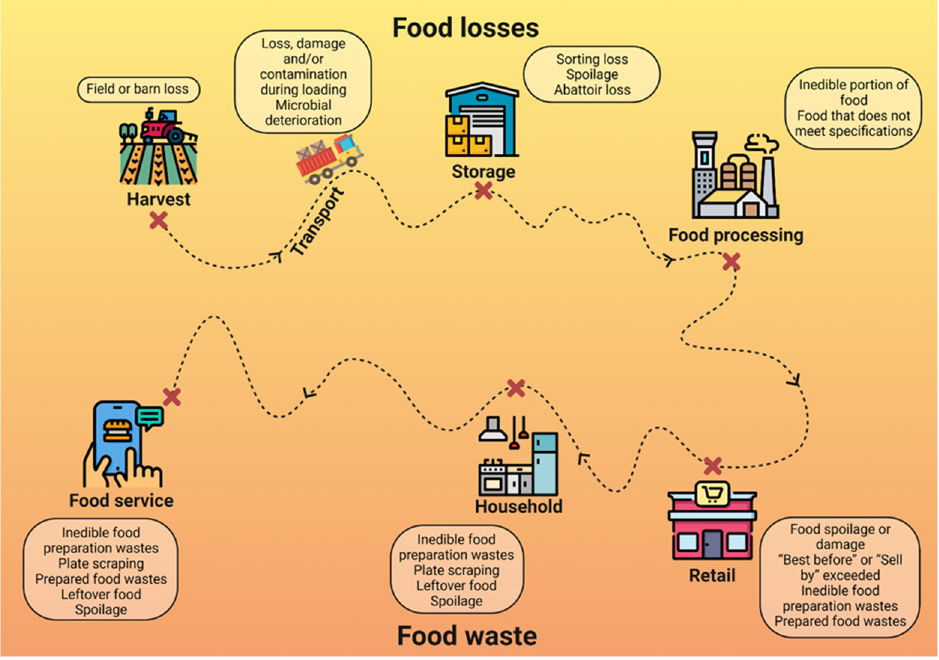
Figure 1. The food chain supply stages and reasons for food waste/loss occurrence at every stage [10] .